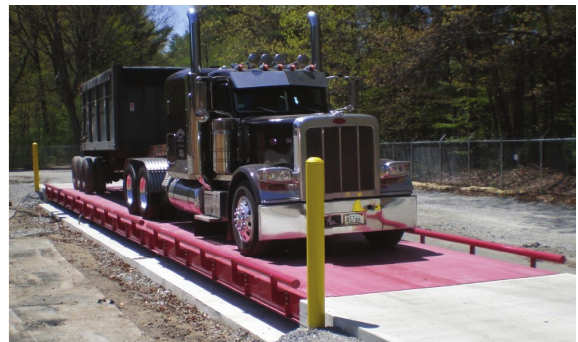
Figure 1: Scale with platform systems for the proposed Land Ferry